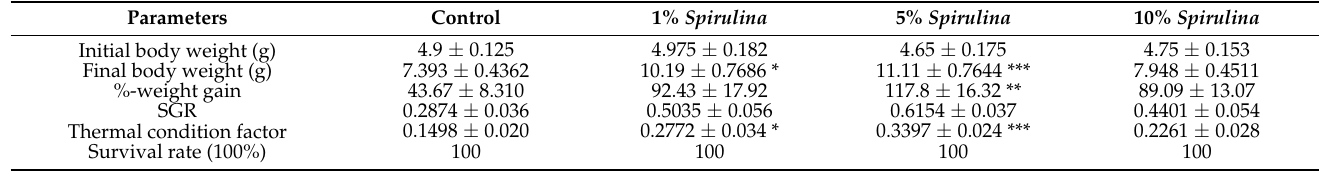
Table 3. Growth performance of grass carp fed with 0, 1, 5, and 10% Spirulina for 90 days. Parameters Control Initial body weight